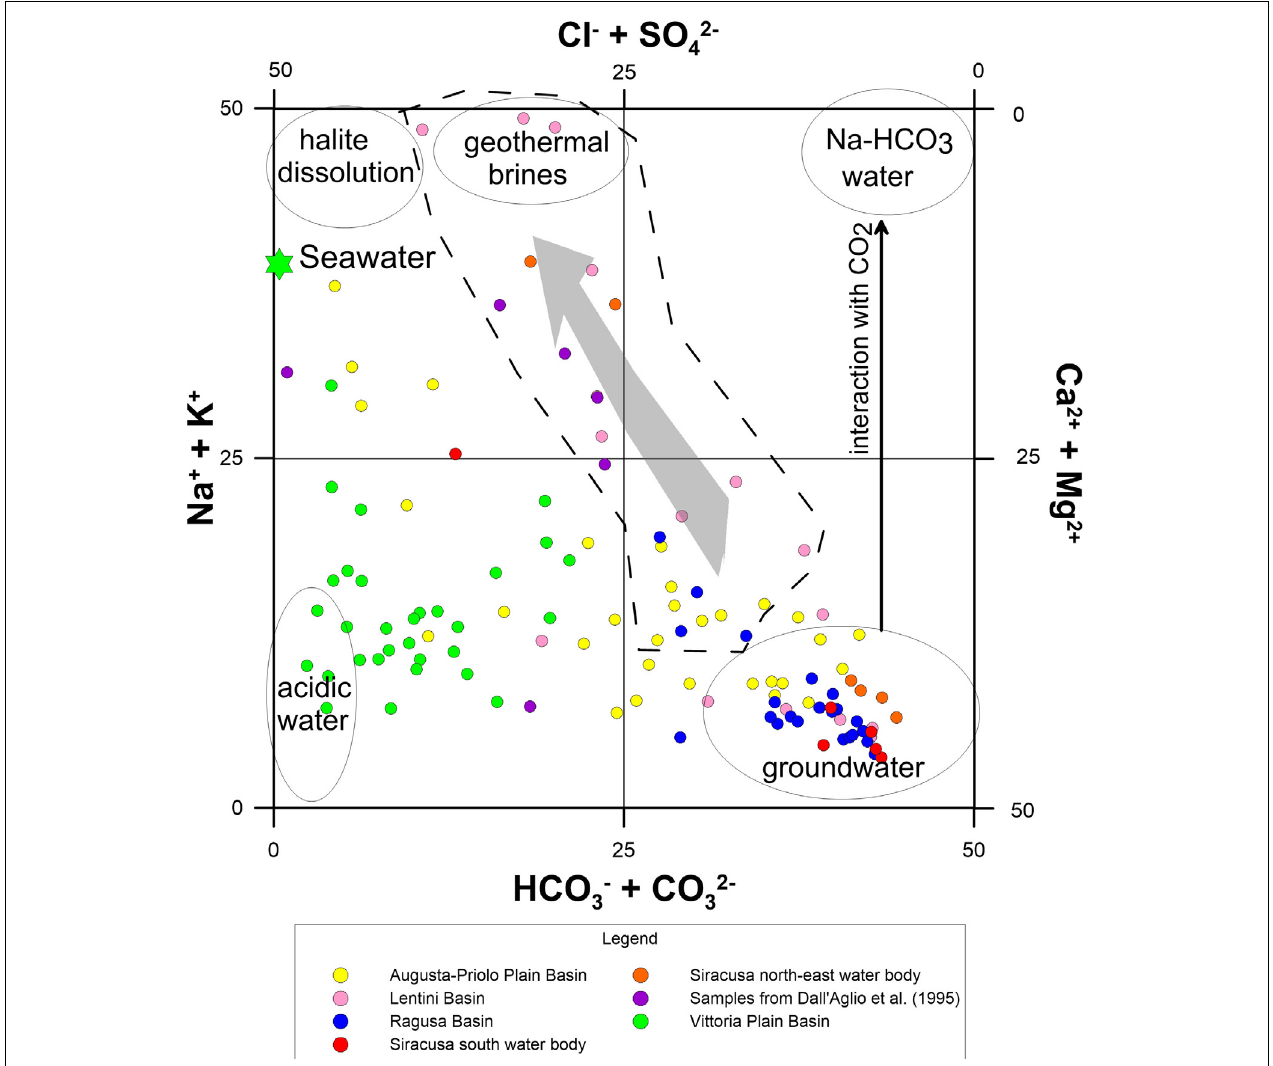
FIGURE 3 | Langelier-Ludwig diagram related to analyzed waters. It shows a wide range in chemical composition, with the majority of the sites displaying a bicarbonate alkaline-earth composition characteristic of most of the groundwaters flowing into shallow aquifers. A second group of samples shows a composition highly enriched in SO 42 - and secondarily in Ca 2 + . These sites belong to the same basin, placed near the town of Vittoria, where most of the land is broadly cultivated with grapes. Presumably, their composition originates for the most part from pollution by NH 4 -Ca 2 + -SO 42 - wastewaters produced by agricultural activities. Finally, a third important group of waters trends toward an alkali-chlorine composition, from an initial alkaline-earth composition. Part of these waters are likely a result of seawater intrusion, whereas another part of them seems to result from mixing between the typical composition of shallow groundwaters and geothermal brines and therefore have been analyzed in greater detail using